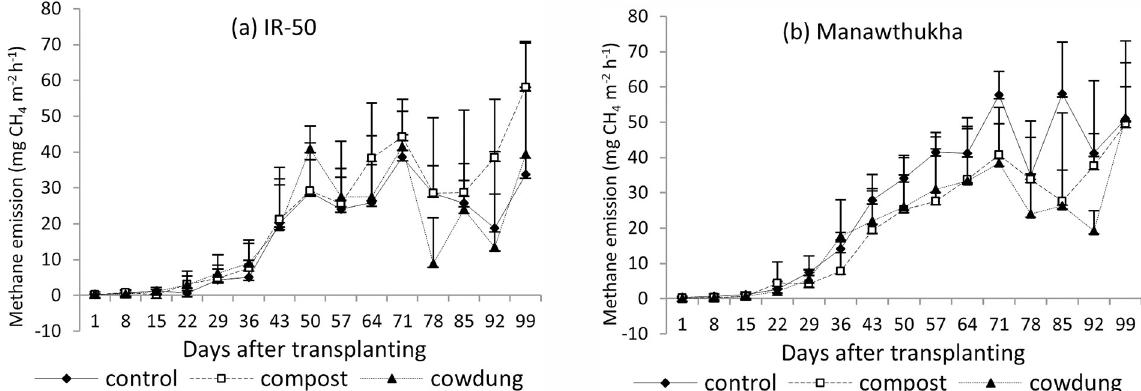
Fig 3. Methane emission of rice varieties at Yezin Agricultural University during the wet season, 2016. Mean value ± standard deviation (n = 3).